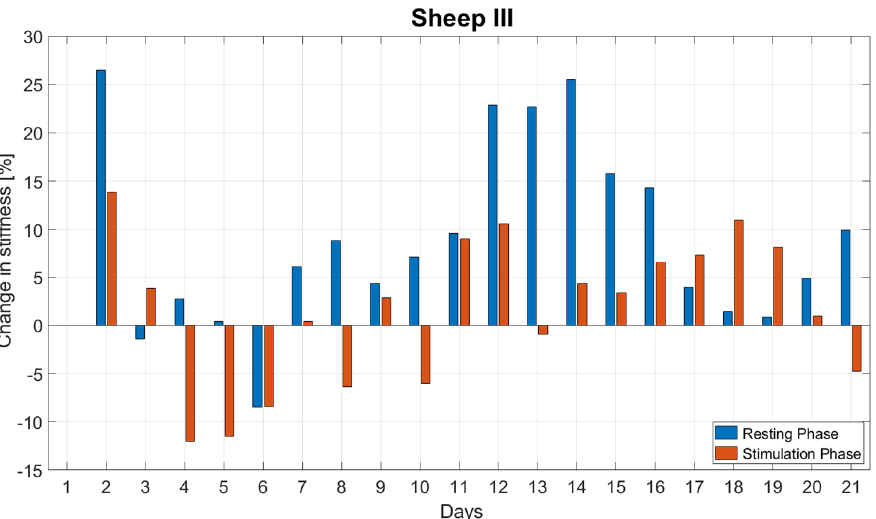
Figure 9. Daily changes in stiffness during the resting and stimulation phases for the first three weeks post-op for Sheep III. The stiffness change during resting was significantly greater than during stimulation ( p = 0.003).